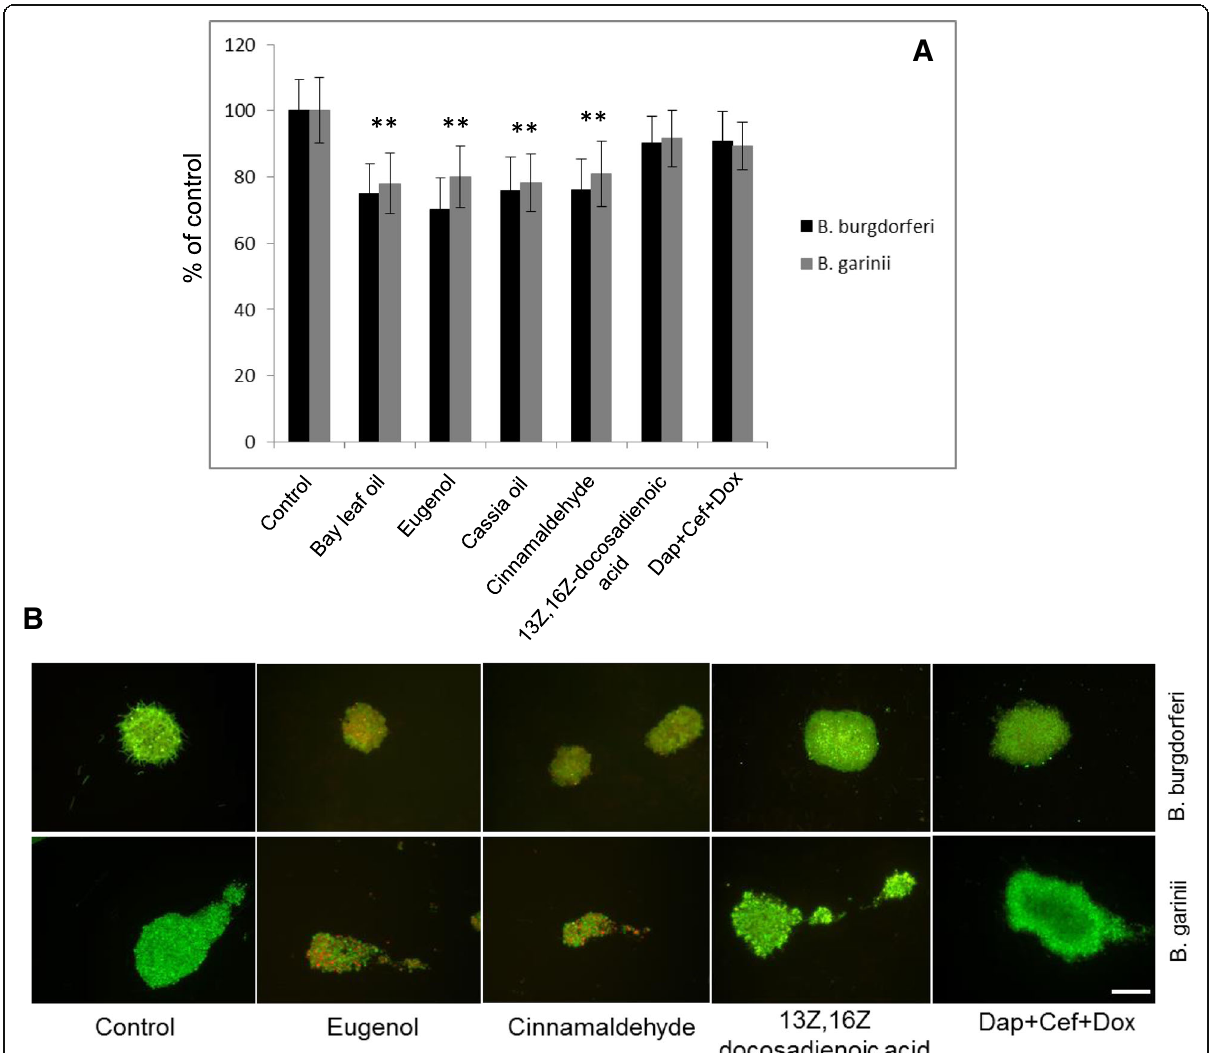
Fig. 3 Susceptibility of Borrelia burgdorferi s.s. and Borrelia garinii biofilm-like aggregates to the test lipids. Biofilm-like aggregates grown on collagen-coated surface were treated with the test lipid (oils at 0.15% including their active ingredients at 0.125% concentration, 13Z,16Z docosadienoic acid at concentration 0.5 mg/ml), for 72 h ( a ). Next, the percentage of eradication of biofilm mass was determined by crystal violet staining method. * p ≤ 0.05 compared to control. Representative live (green)/dead (red) merged images of biofilms of Borrelia burgdorferii s.s. and Borrelia garinii ( b ) after 72 h incubation period with eugenol and cinnamaldehyde, as the active compounds of the most effective oils, 13Z,16Z- docosadienoic acid, and daptomycin+cefoperazone+doxycycline (Dap+Cef + Dox) as a positive control, taken at 200 x magnification, stained with BacLight dye; scale bar 50 μ